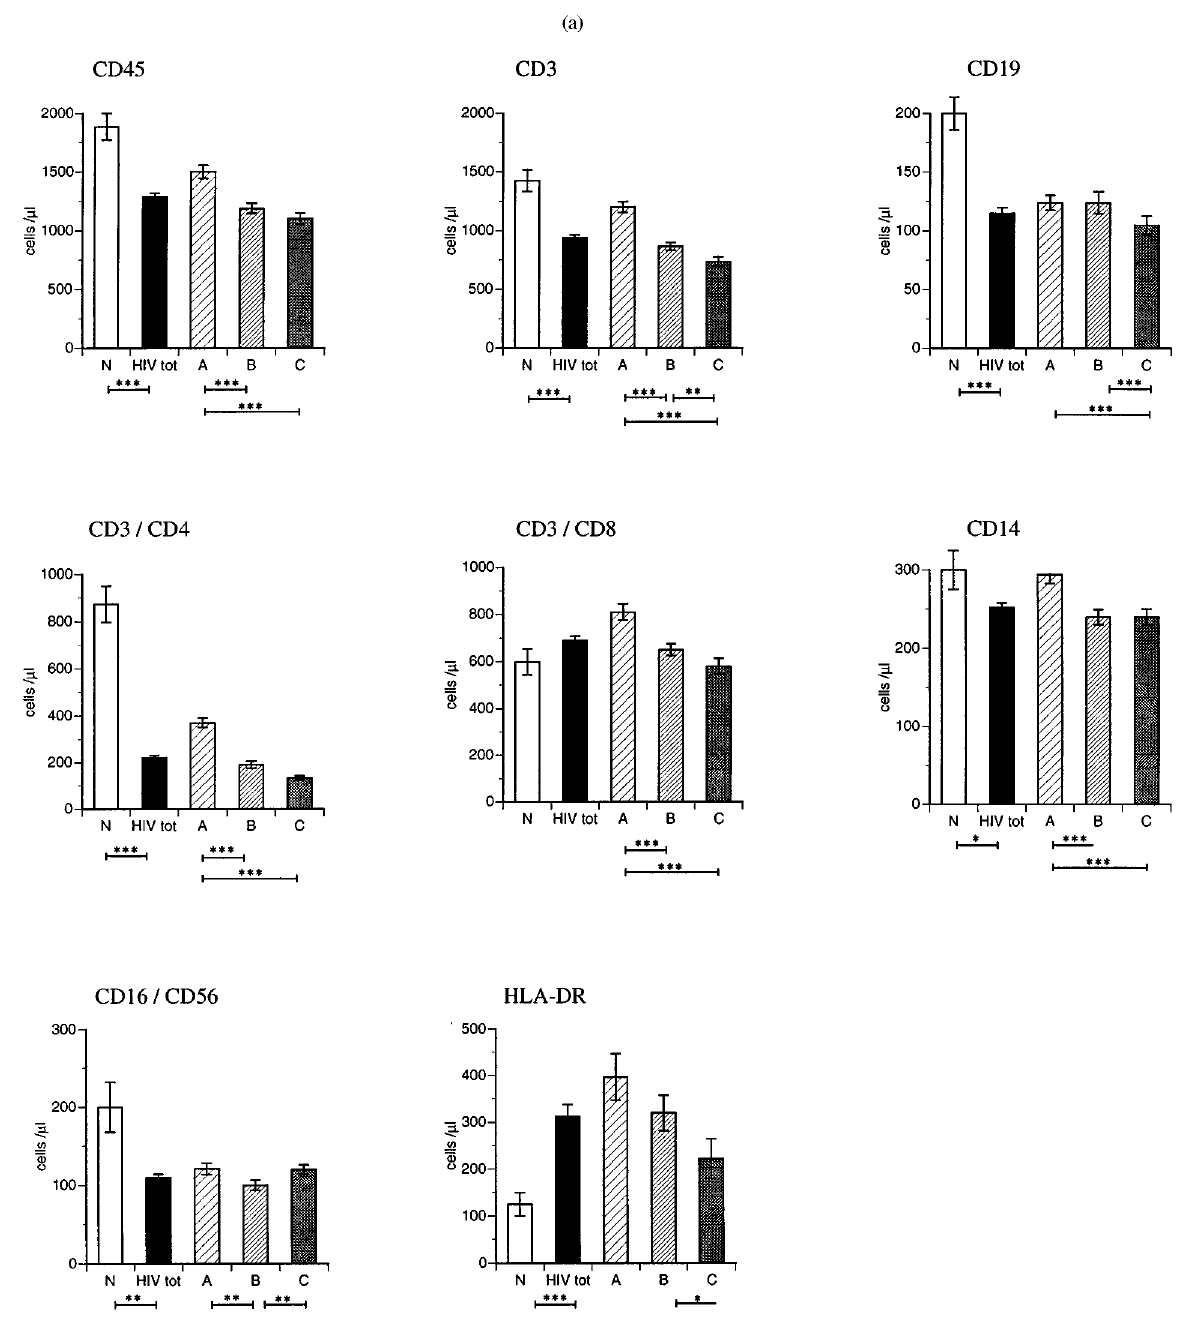
Fig. 1. Median values (cid:6) one standard error on the median of immunological markers (a), and of annexin-V level, intermediate PI permeability and (cid:13) -GT activity (b,c,d,e) measured in PBMC isolated from healthy donors (N), from the total HIV population (HIV tot), and from subclinical groups A, B and C. *; **; ***: significantly different ( p < 0 : 05; p < 0 : 01 and p < 0 : 001, respectively). Continued on next